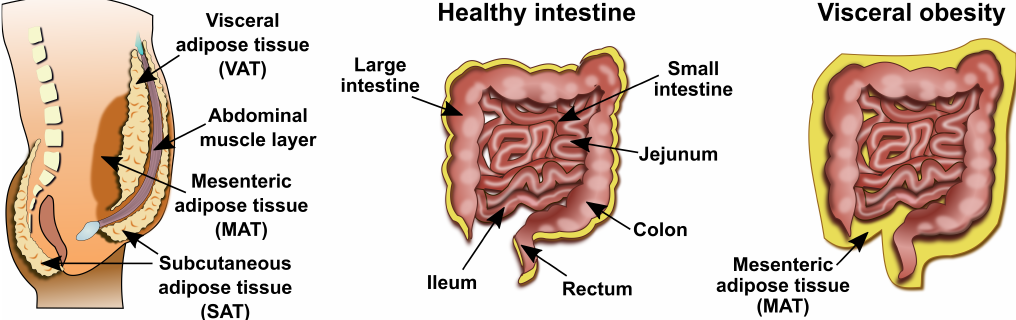
Figure 1. Classification of adipose tissue according to its anatomical location and distribution of visceral fat in health and